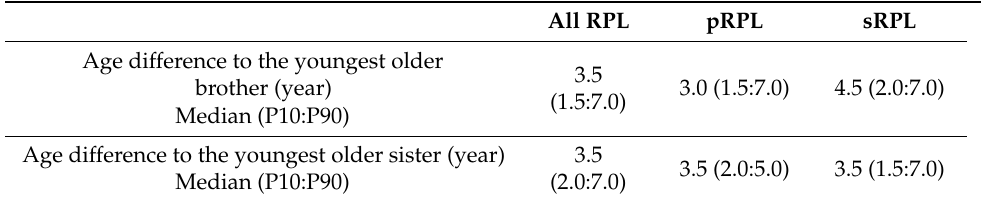
Table 3. Age difference from the proband to her youngest older sibling in all RPL patients and in pRPL and sRPL